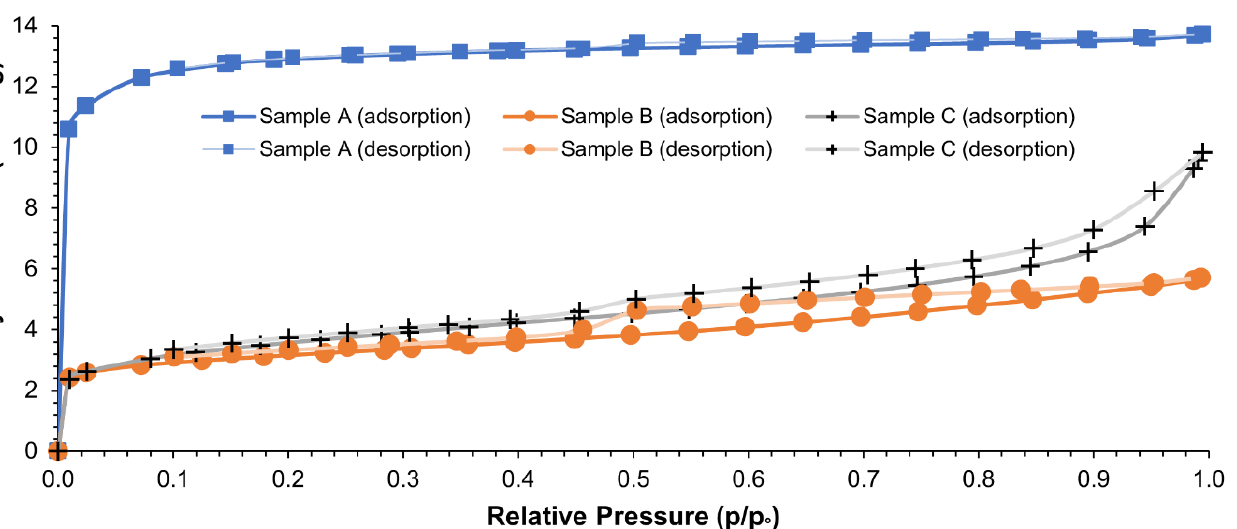
Figure 3. Pore size distribution of CARBOSORB NC 1240 ® , AMBIOTON ® , and RE-CHAR ® . As shown in Figure 2, both biochars presented a type IV isotherm of the IUPAC clas- sification with an H4 hysteresis loop ranging from 0.45 to 0.98 p/p 0 , which is typical of many mesoporous industrial adsorbents. Furthermore, the profile of the hysteresis curve indicates that the pores are open tubular in shape [118]. The hysteresis loop of RE-CHAR ® is narrower than that of AMBIOTON ® , so the mesopores amount of the former is inferior to that of the latter, as shown in Figure 3. Furthermore, CARBOSORB NC 1240 ® shows a rapid increase at low relative pressure (p/p 0 < 0.1), suggesting the existence of a good amount of micropores (0.398410 cm 3 /g), compared to AMBIOTON ® and RE-CHAR ® (0.057996 and 0.035743 cm 3 /g, respectively). Table 2 summarizes the specific surface area (S BET , m 2 /g), pore volume (V T , cm 3 /g), and average pore size (d, Å) obtained from BET and BJH analyses, respectively.